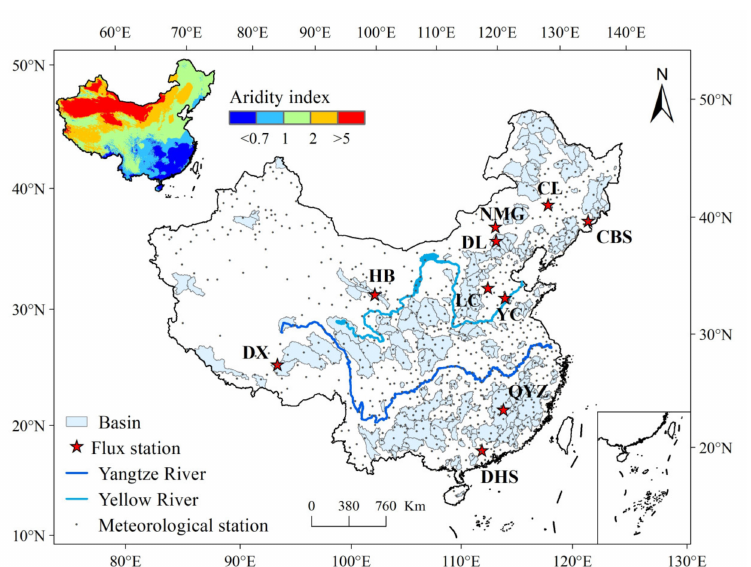
Figure 2. Locations of the meteorological stations (grey dots), flux stations (red stars) and 286 test basins. The insert shows the spatial pattern of the aridity index, which is defined as the ratio of potential ET (PET) to precipitation (P) at the mean annual